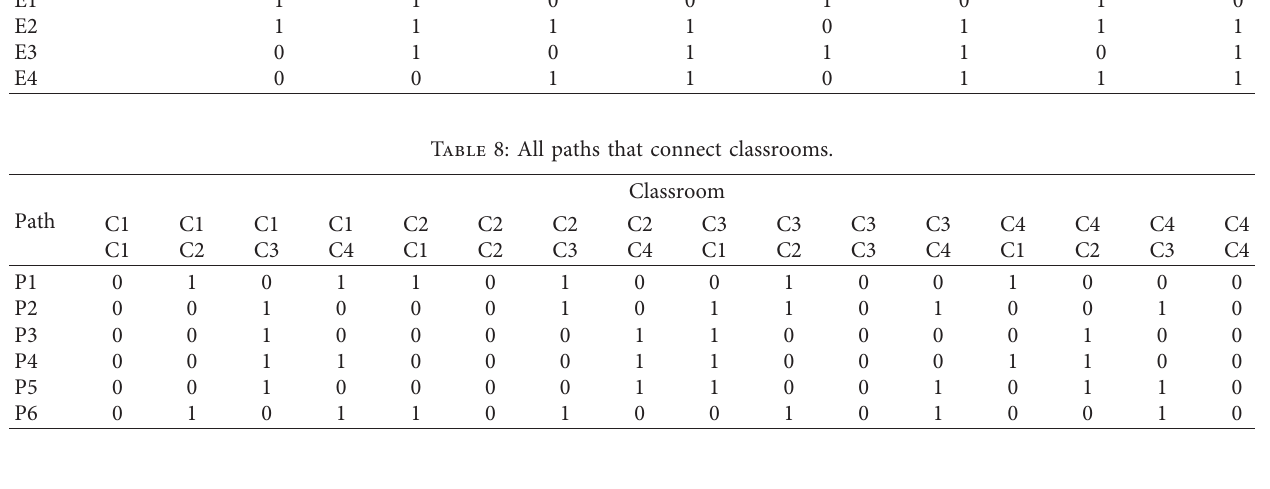
Table 9: Timetable of the random example.